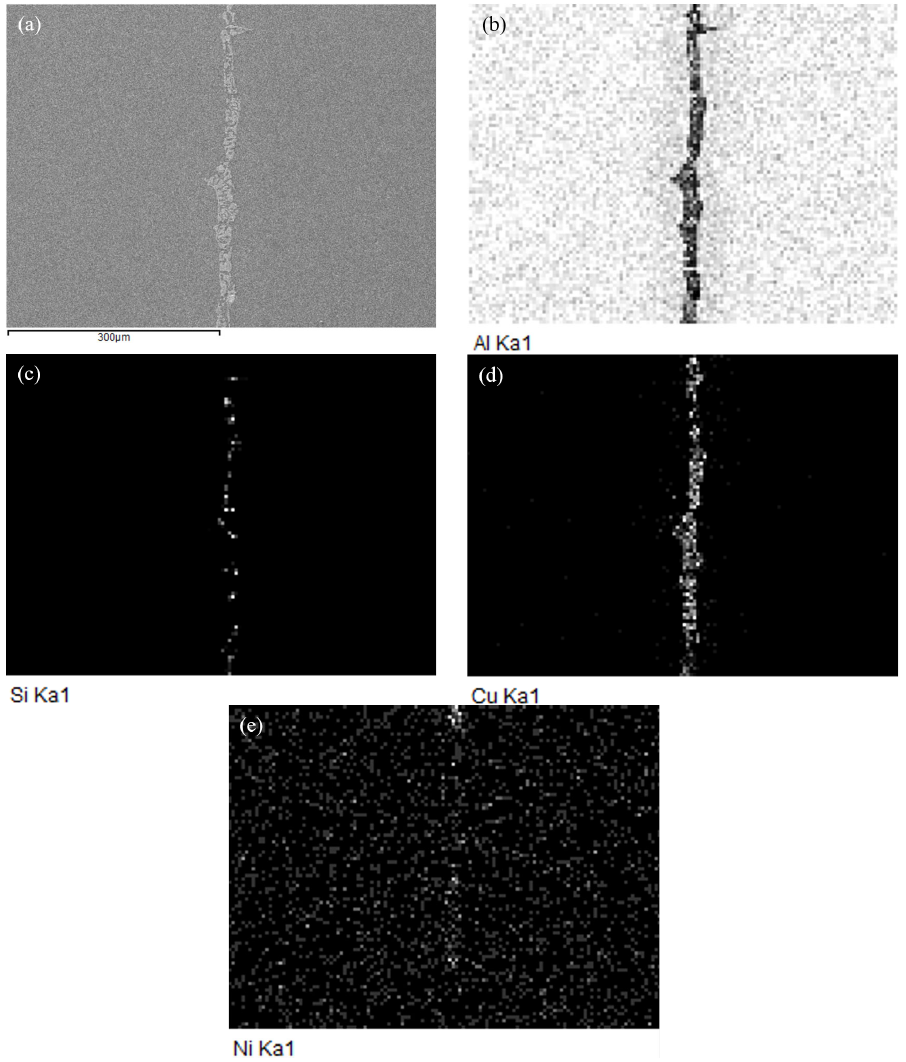
Figure 9. SEM micrograph at the interface of 3003 joint brazed at 575 °C for 20 min, and energy dispersive X-ray maps showing distribution of elements: ( a ) SEM image; ( b – e ) individual elemental mapping of Al, Si, Cu and Ni, respectively.